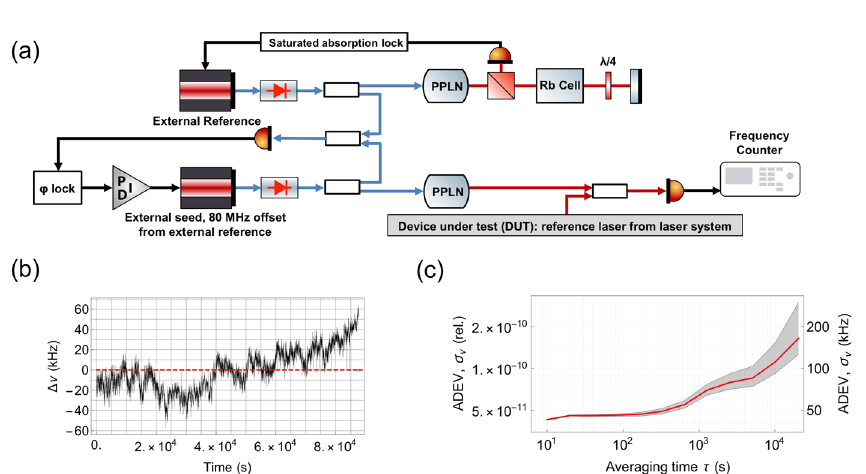
Figure 7. Schematic and test of the reference seed frequency stability test versus an external reference laser. ( a ) We compare our reference seed laser with a separate, external reference laser, pictured here, through an offset beatnote. This external reference laser is frequency-stabilized to the same transition; an external seed is 80 MHz detuned and frequency-stabilized to this external reference. We then compare our reference seed signal, the DUT input, to this external seed laser. ( b ) Raw data of the frequency drift with respect to the set point over time. Maximum difference seen in 25 hours is 64.5 kHz. ( c ) Overlapping Allan deviation of the drift, with respect to the optical frequency. The shaded regions show the minimum and maximum